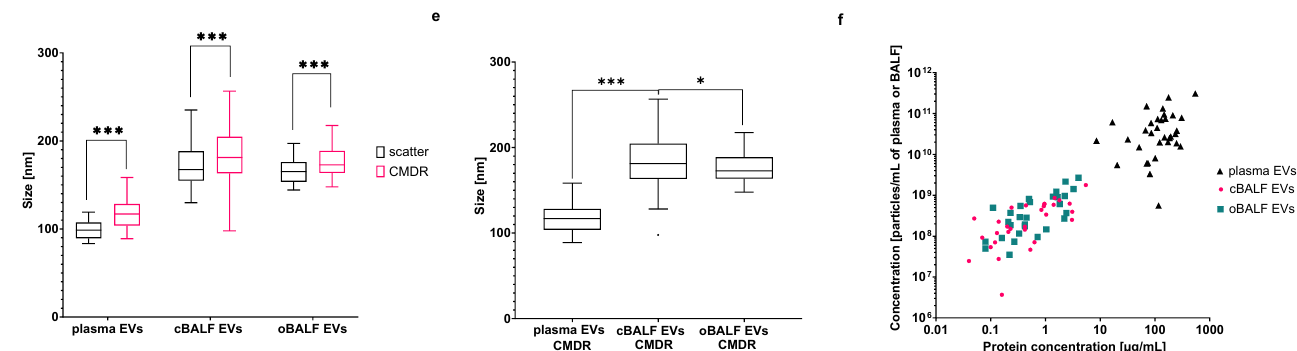
Figure 4. CMDR labeling of EVs. ( a ) Distribution of particles in scatter and fluorescent mode (640 nm) for EVs from plasma and cBALF. A representative NTA histogram of one patient is shown. ( b ) Concentration of particles measured in fluorescent mode (640 nm) depending on the volume of the EV sample taken to measure the BALF and plasma EVs of one patient. A line from simple linear regression with CI and R 2 was plotted for both types of EVs. ( c ) The percent of CMDR-positive particles in comparison to all particles visible in scatter mode for all analyzed EV types. ( d ) Comparison of EV mode sizes measured in scatter and after CMDR labeling within the three analyzed EV types. ( e ) Comparison of the mode sizes measured after CMDR labeling of the three analyzed EV types. ( f ) Correlation between the concentration of particles and protein concentration for plasma and BALF-EVs after CMDR staining. Graph ( c ) presents mean and SD for all patients. Graphs ( d , e ) presents a Tukey plot for all patients. *** refers to p value ≤ 0.0002, * refers to p value ≤ 0.05, ns refers to p value > 0.05 from t -test-paired